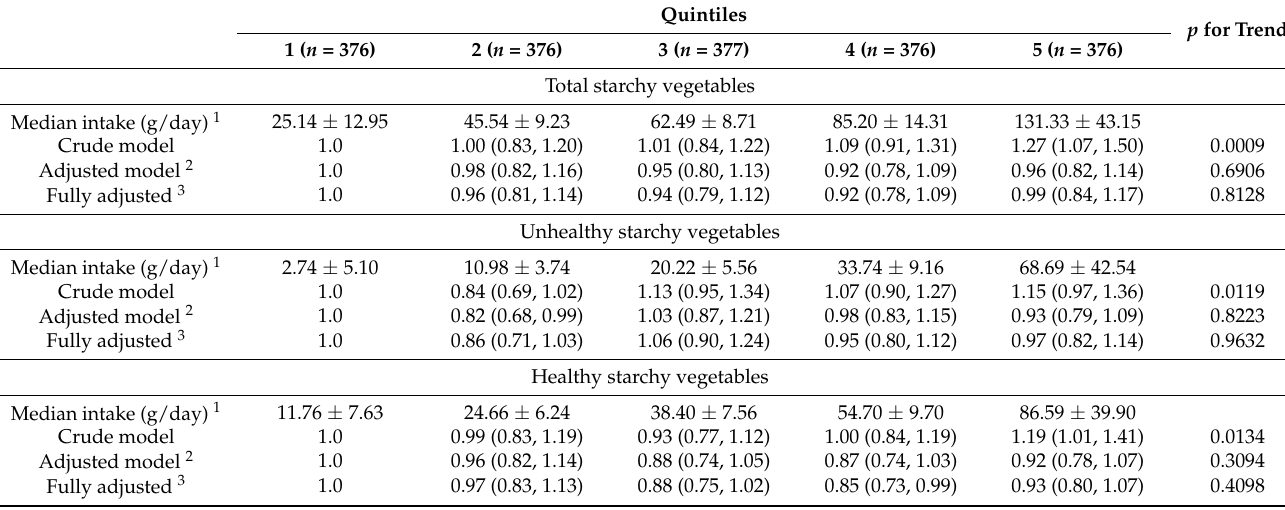
Table 2. Prevalence ratios of metabolic syndrome according to quintiles of total starchy vegetables, unhealthy starchy vegetables, and healthy starchy vegetables consumption ( n = 1881).